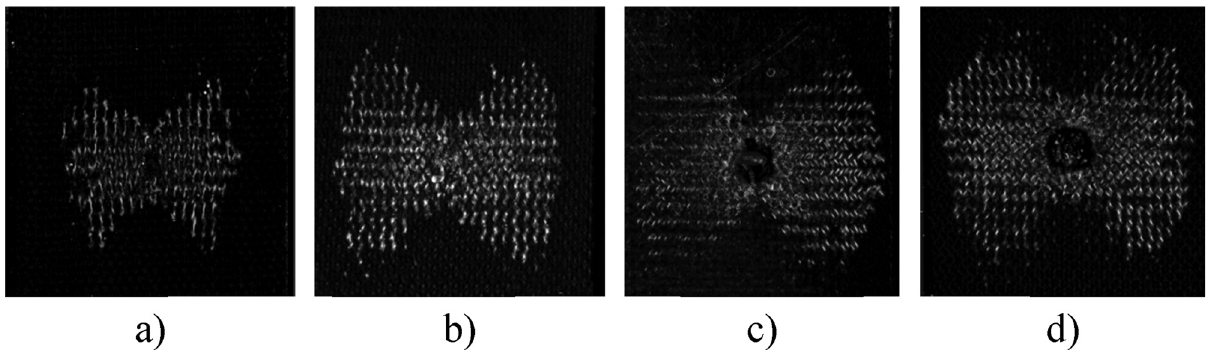
Figure 8: Internal damage of 30° braided angle specimens after impact of spherical punch: ( a ) 1 impact, ( b ) 5 impacts, ( c ) 20 impacts, and ( d ) 44